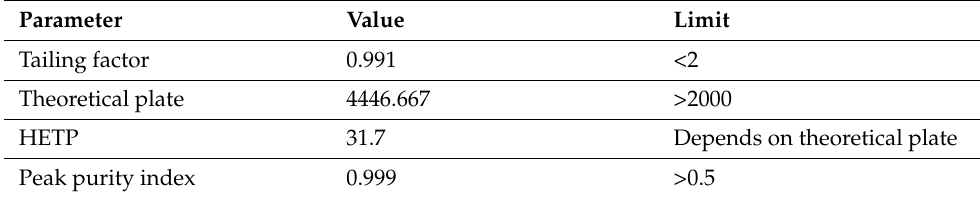
Table 7. Depicting system suitability